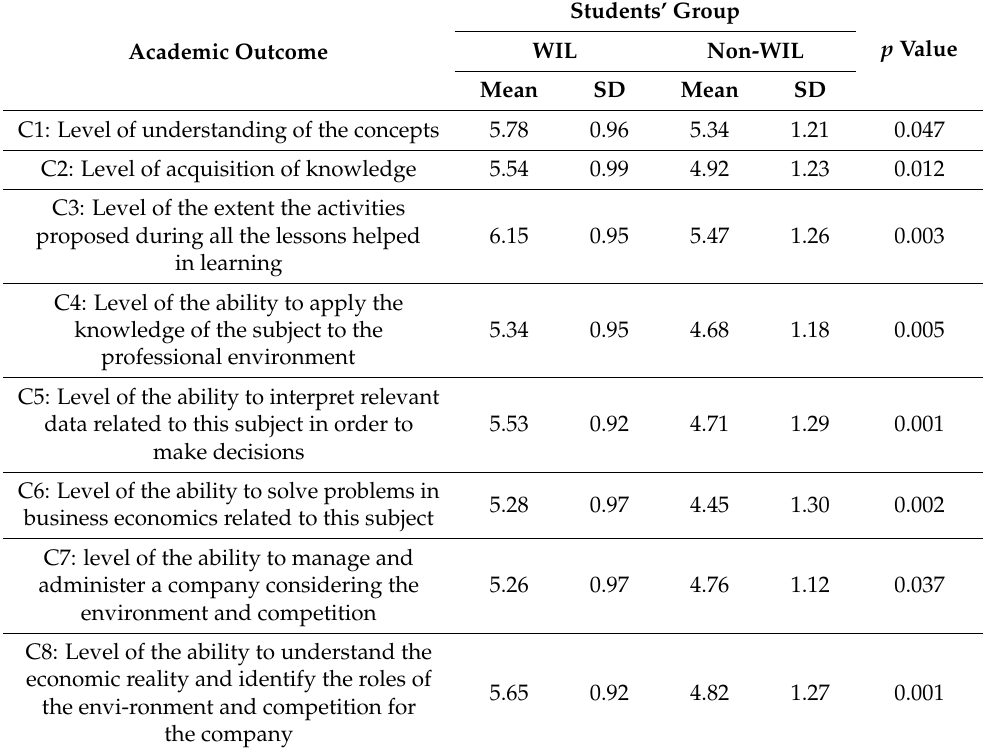
Table 1. Average scores given by each group of students (WIL and non-WIL) to the learning com- petences of the subject Introduction to Marketing.